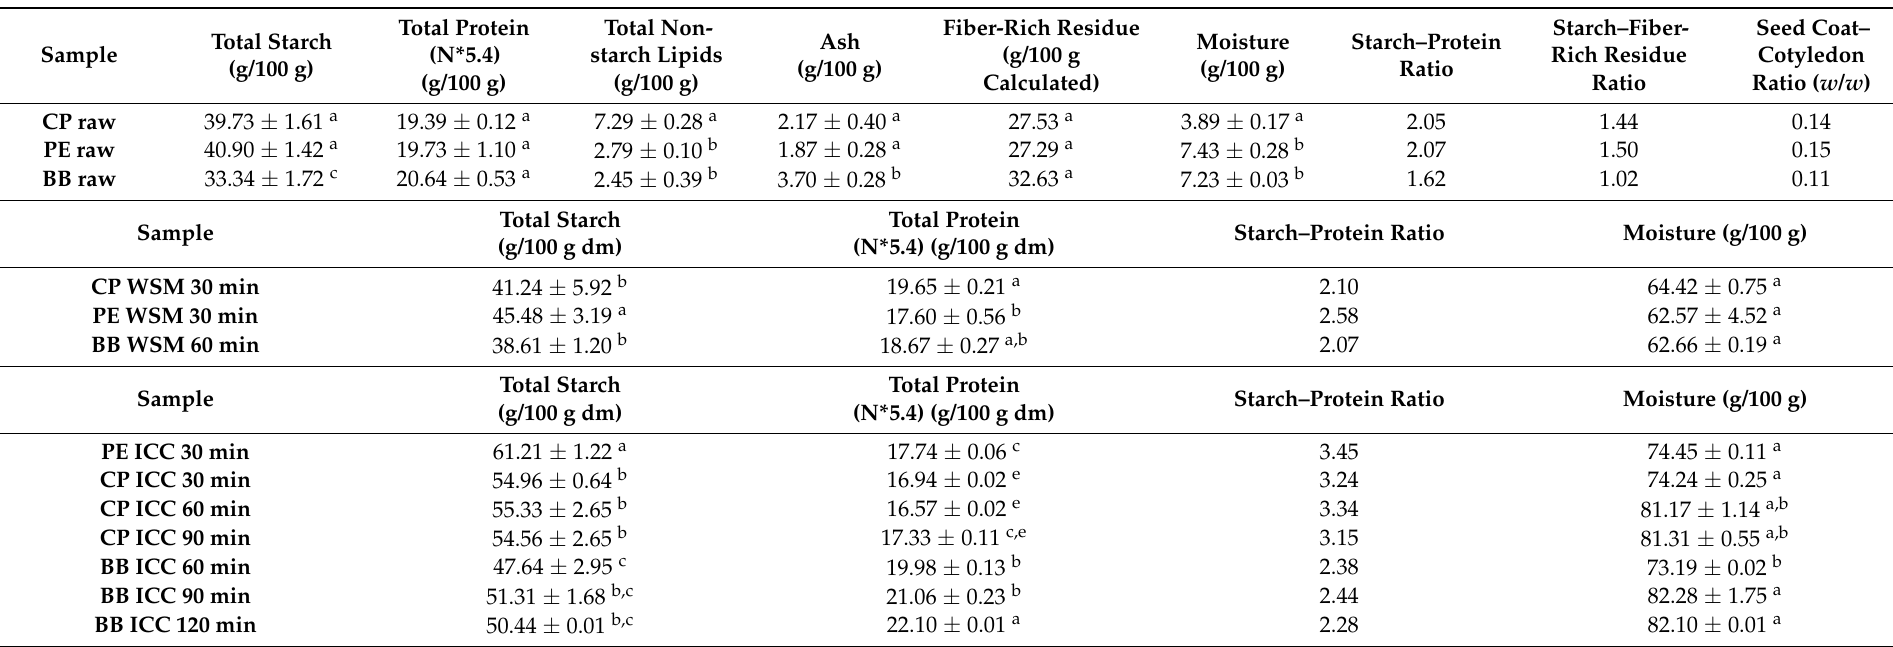
Table 1. Proximate composition ± standard deviation of raw (per 100 g ingredient) and hydrothermally processed (per 100 g dry matter (dm)) chickpea (CP), pea (PE), or black bean (BB) seeds. Mean values (within a column) with different superscript letters are significantly different ( α = 0.05). The composition of isolated cotyledon cell fractions (ICC), as well as for the whole seed material (WSM) of chickpea, pea, or black bean, are reported for the hydrothermally treated pulses (95 ◦ C, t